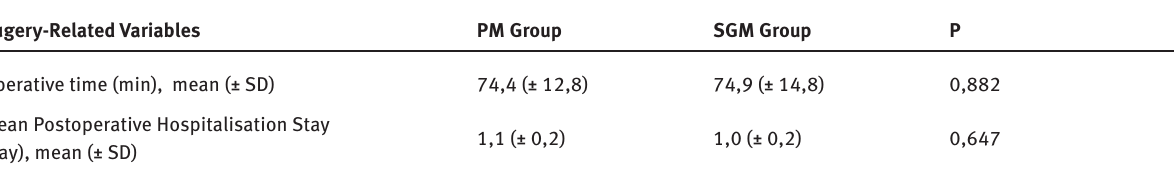
Table 2a: Surgery-Related Variables